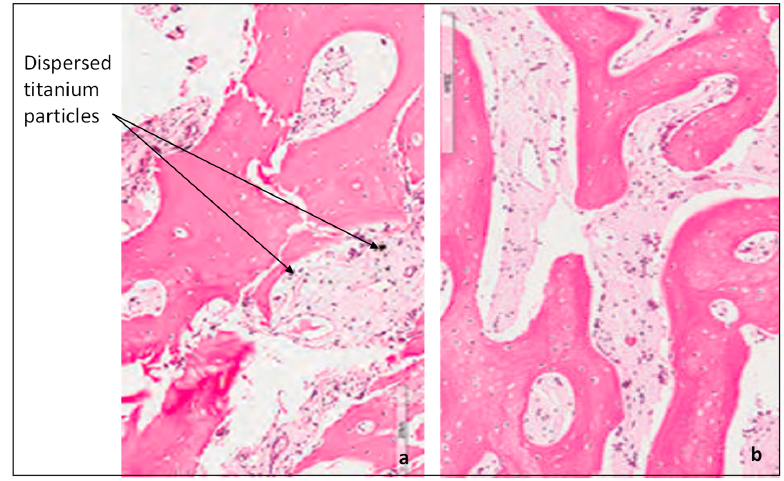
Figure 13. Histological analysis of specimens showing ( a ) mild inflammatory and sub-micrometer particles of dispersed material within the bone and ( b ) islands of newly formed cancellous bone and neovascularization interspersed with the connecting